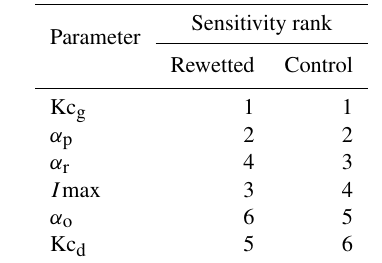
Table 4. Sensitivity rank of the parameters of the hydrological model.